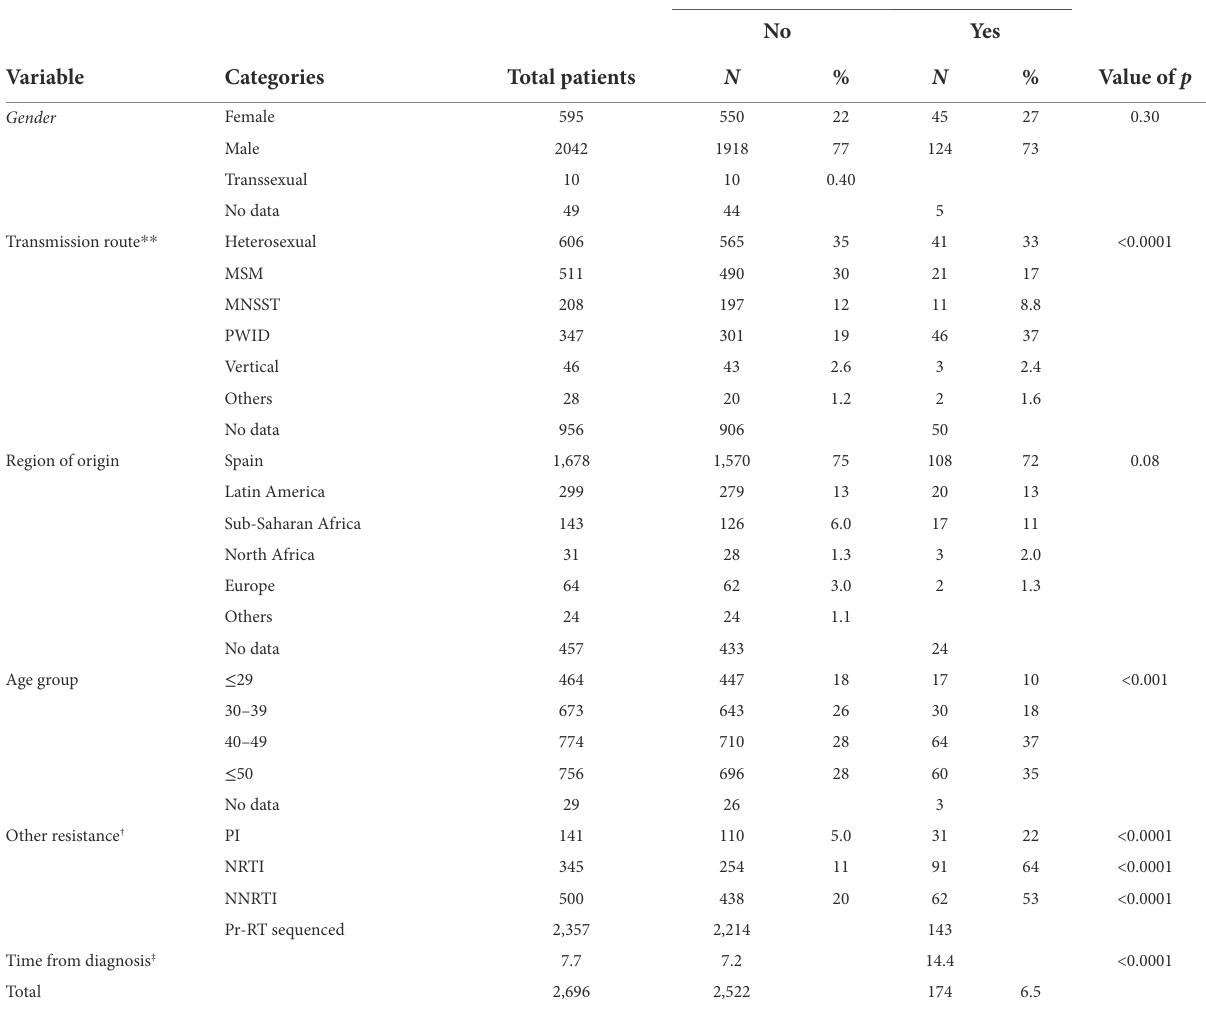
TABLE 1 Characteristics of the patients with INSTI resistance included in the